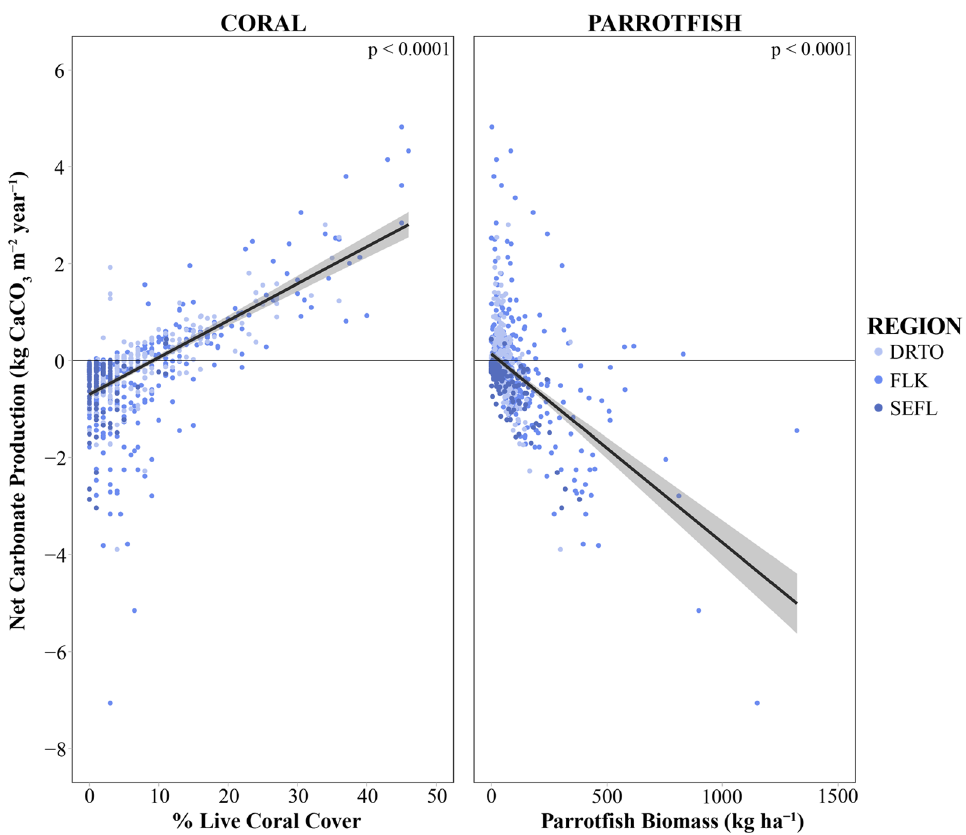
Figure 2. Primary biological drivers of reef development in South Florida. Linear regression plots of net carbonate production (kg CaCO 3 m −2 year −1 ) in relation to ( a ) % live coral cover and ( b ) parrotfish biomass (kg ha −1 ) for DRTO, Dry Tortugas (light blue); FLK, Florida Keys (blue); and SEFL, Southeast Florida (dark blue). Data from all three biogeographic regions were pooled together for the statistical analysis. Grey zonation surrounding regression lines represents 95% confidence